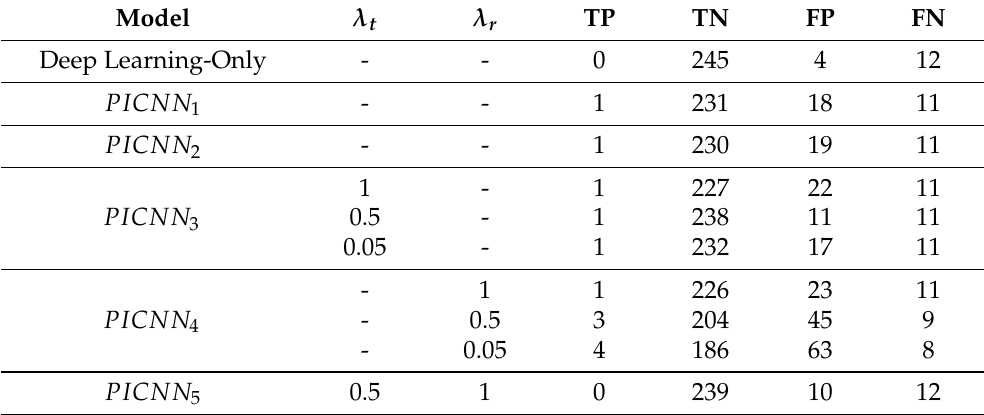
Table 5. The number of true positive (TP), true negative (TN), false positive (FP), and false negative (FN) predictions for the baseline deep learning-only model and each version of the physics-informed model when tested on the test data